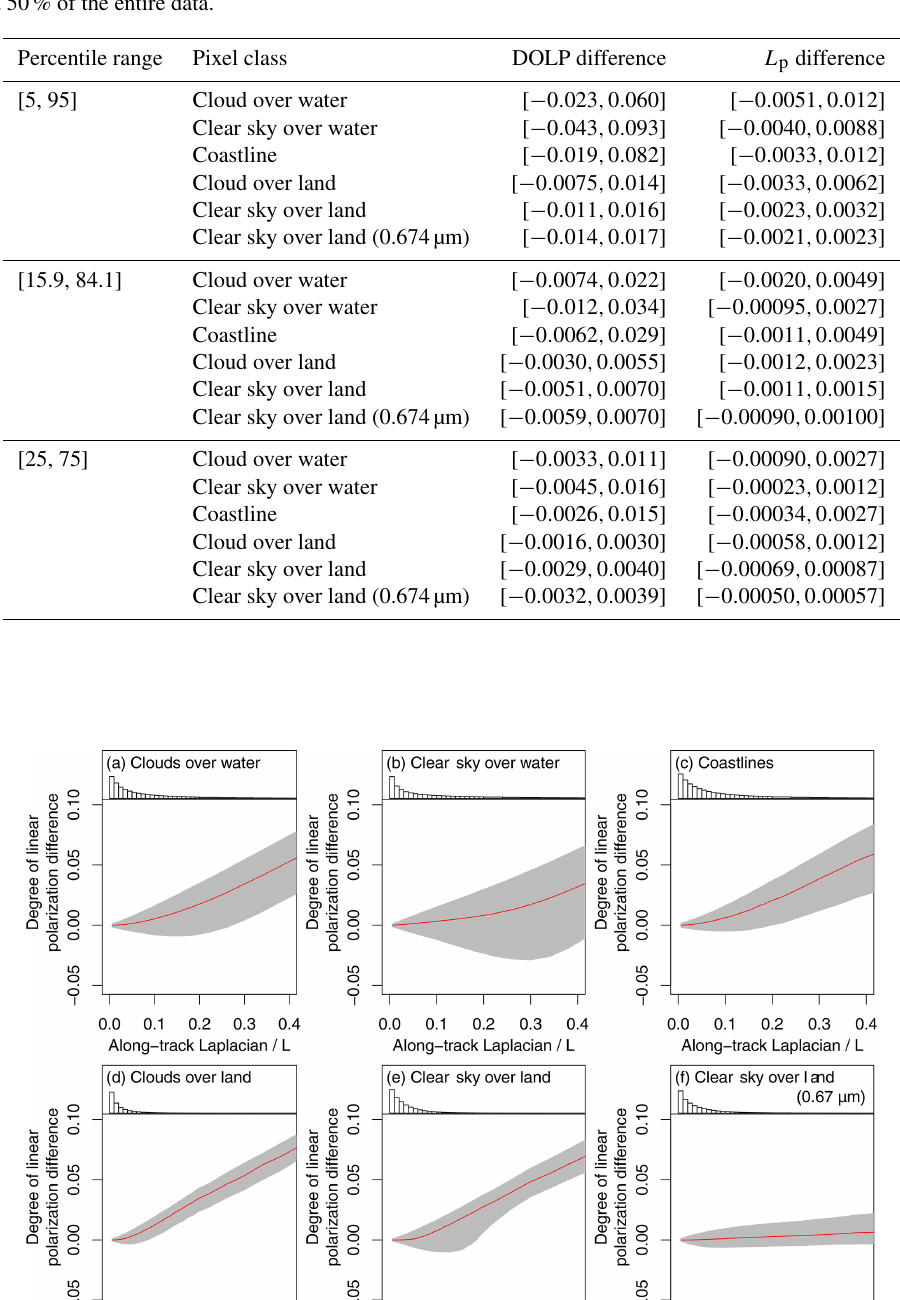
Table 6. The intervals of degree of linear polarization (DOLP) difference and polarized normalized radiance ( L p ) difference for percentiles that cover 90% and 50% of the entire data.